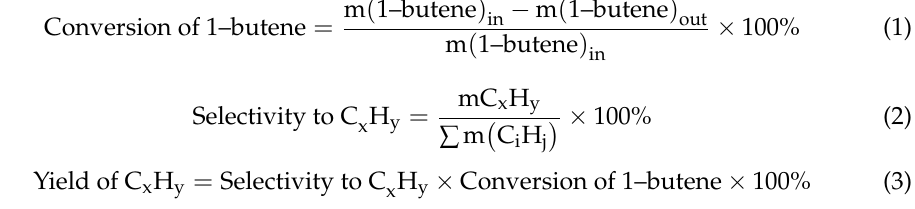
SAPO-34. Figure S2: The conversion of 1-butene for commercial SAPO-34 catalysts with time on stream. Reaction conditions: WHSV = 1.5 h − 1, P = 0.1 Mpa, T = 500 ◦ C. Figure S3: TG profiles of coked SP-0.6 catalyst and commercial SAPO-34 at 150 min. Table S1: Product distribution of 1-butene catalytic cracking over commercial